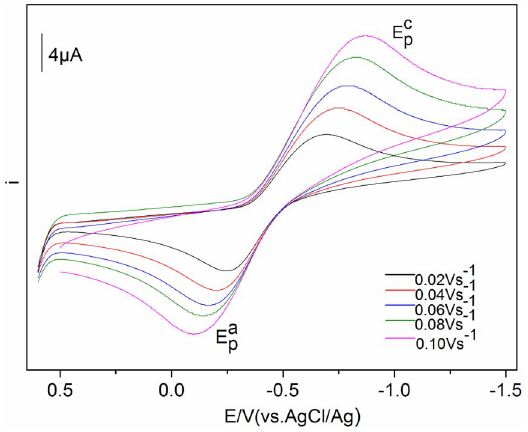
Figure 4. Plots of cathodic peak current intensity ( i p ) against square-root of the potential scan rate ( n 1/2 ); & , Eu(III); N , Sm(III); m , Dy(III); . , Nd(III).